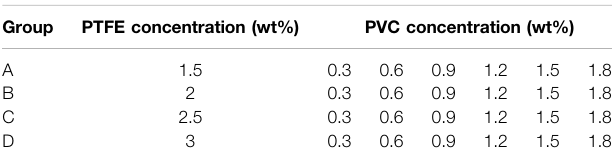
TABLE 3 | Group of particle combinations.